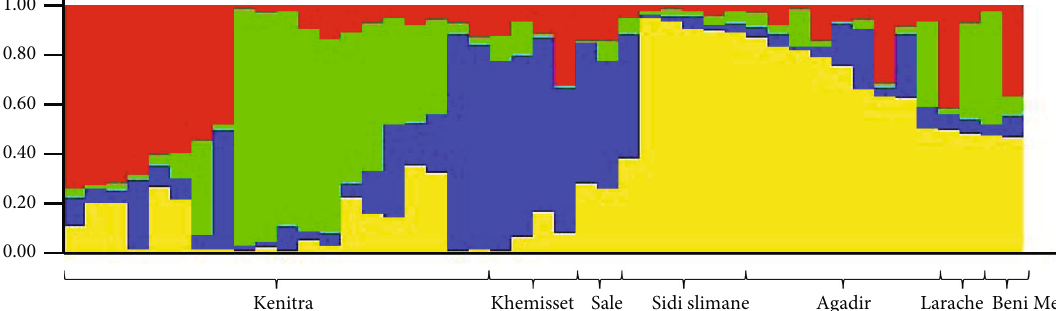
Figure 3: Genetic assignment of the Alternaria populations using the STRUCTURE program at K = 3 and Bayesian method. Ag21, Citrus, Morocco, A. alternata